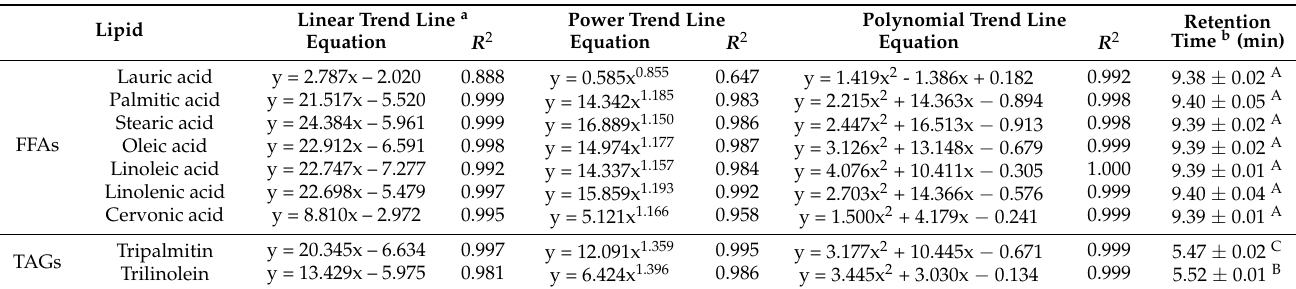
Table 2. Equations and R-squared values of linear, power and polynomial trend lines fitted to the evaporative light scattering detection response as a function of the analyzed lipid mass for different free fatty acids (FFAs) and triacylglycerols (TAGs) (Figure 2). Also listed are the retention times of the FFAs and TAGs. Column values with differing letters are significantly different from each other ( p <